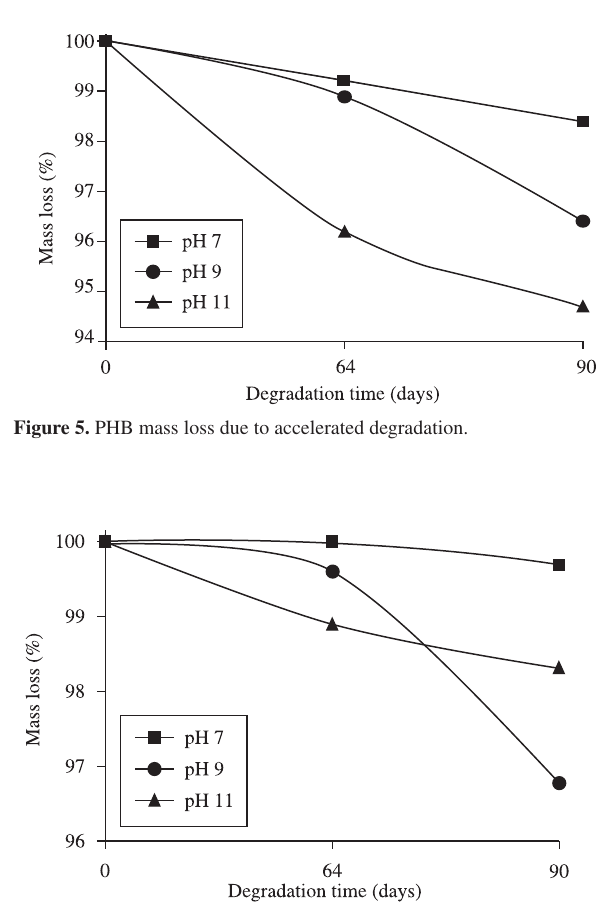
Figure 6. PHB/PP (90/10) mass loss due to accelerated degradation.